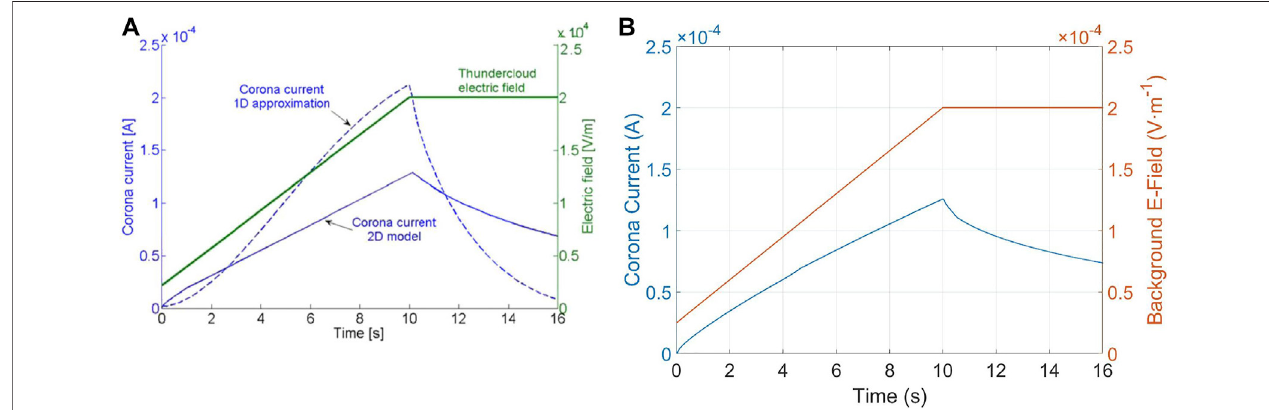
FIGURE 4 | Comparison of corona currents at the tip under a certain environmental E- fi eld obtained by using two models. (A) is the result of Becerra ’ s model, and (B) is the result of the proposed model.